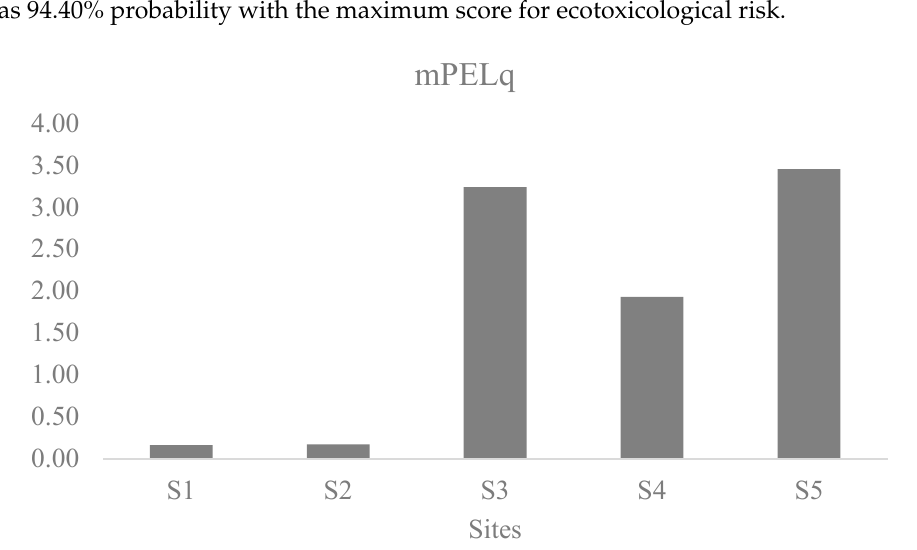
Figure 2. Potential ecological risk index in sediments across the sites. PERI = Potential Ecological Risk Index.